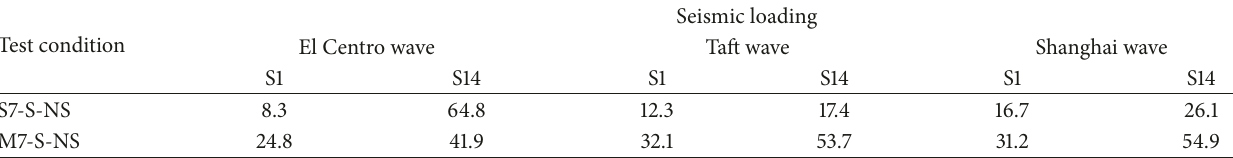
Table 4: The maximum strain of concrete at the points S1 and S14 ( 𝜇𝜀